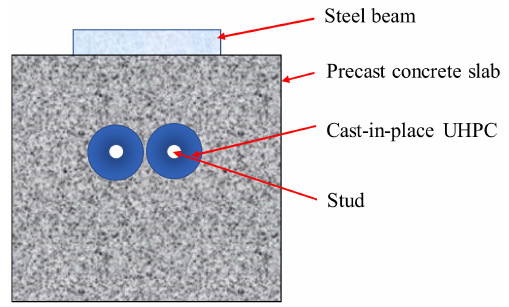
Figure 5. Schematic representation of the